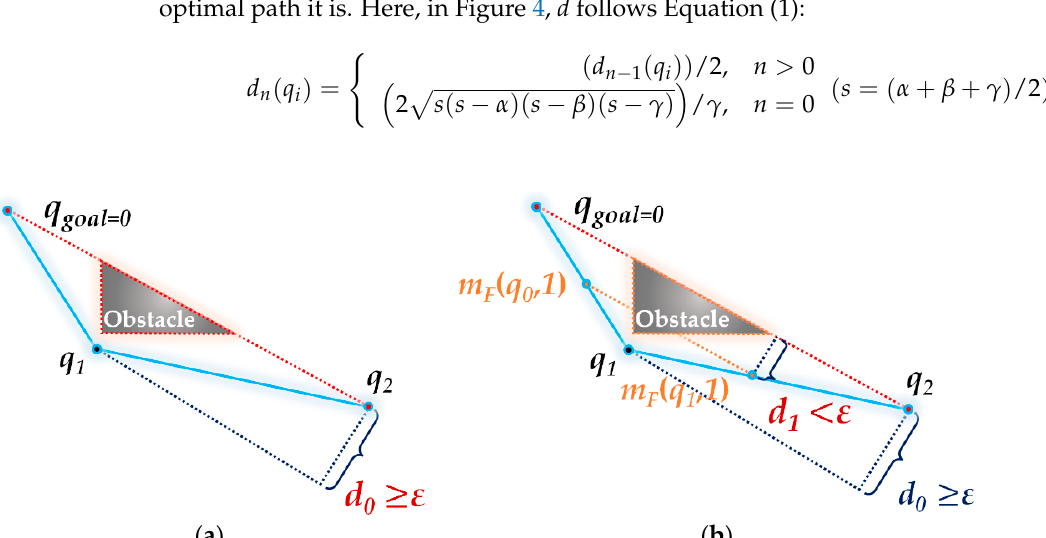
Figure 3. Summary of post triangular processing of the midpoint interpolation method: ( a ) line segment γ with node q 0 and its grandparent node q 2 in tree R is not free from obstacle collision; ( b ) Parent node q 1 of q 0 is deleted, and q a between q 0 and q 1 , and q b between q 1 and q 2 are inserted as waypoints of a new path between q 0 and q 2 . Figure 4. Interpolation function of post triangular processing of the midpoint interpolation method: ( a ) height d 0 of the triangle formed by waypoints q 0 , q 1 , and q 2 of the path is greater than ε (interpolation continuation); ( b ) height d 1 of the triangle formed by midpoints m F ( q 0 ,1) and q 1 of q 0 and q 1 and midpoint m F ( q 0 ,1) is the midpoint of q 0 and q 1 , also m F ( q 1 ,1) is the midpoint of q 1 and q 2 .